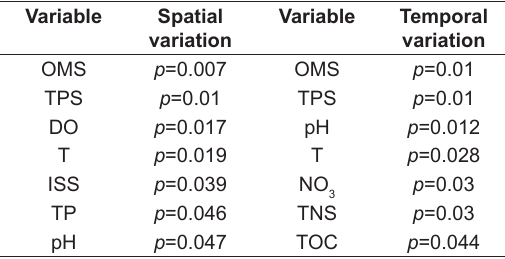
Table 3. Main variables responsible for spatio-temporal variation in Itupararanga Reservoir. Results from MANOVA (significance level p <